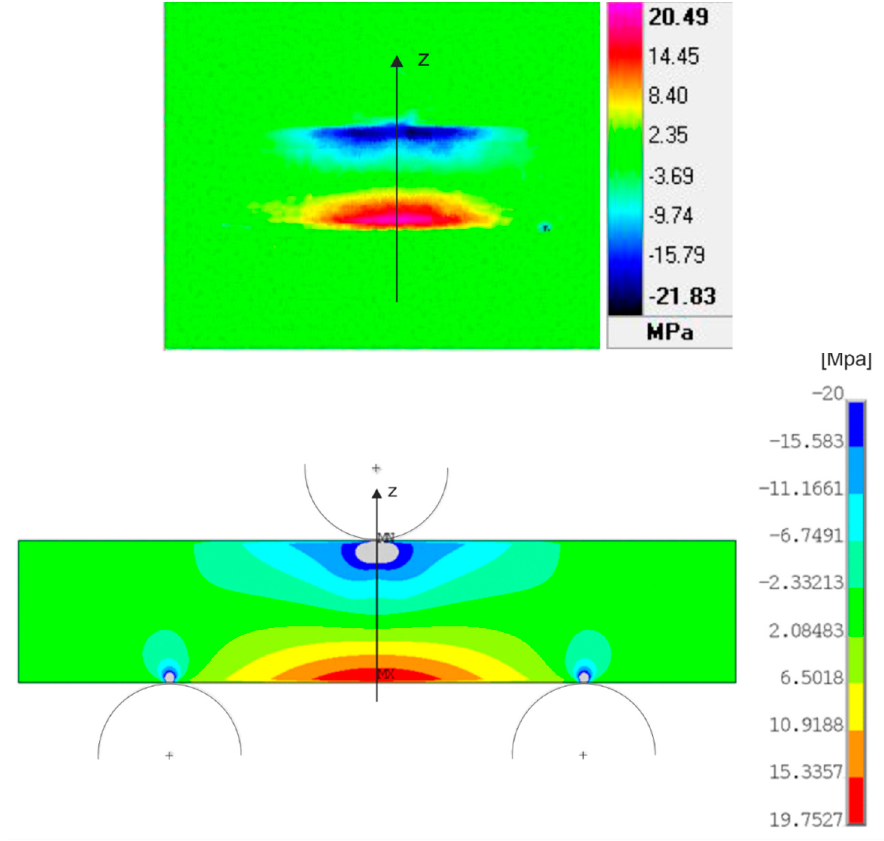
Figure 3. Comparison of the distribution of principal stresses from experimental measurements with the results of numerical analysis, material AISI 316L, and load 0.5 kN.